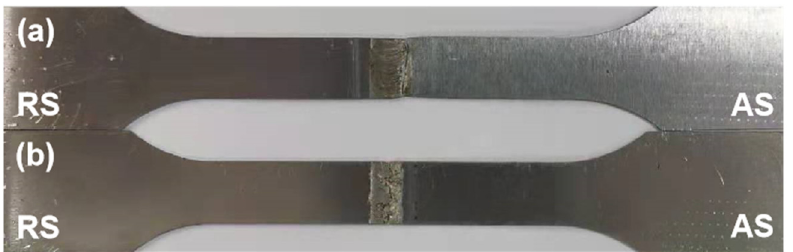
Figure 11. Tensile fracture, ( a ) breaking position at 12,000 rpm; ( b ) breaking position at 6000 rpm.